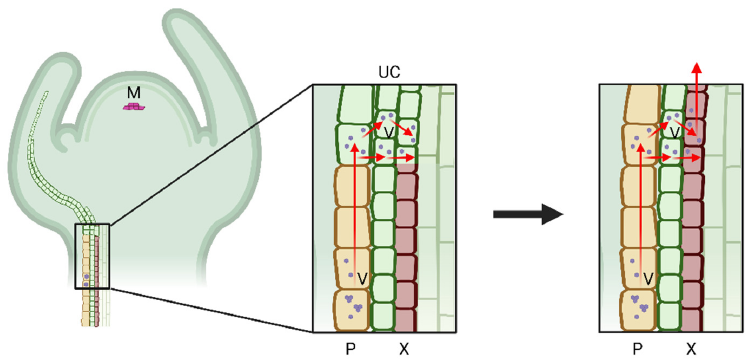
Figure 3. A virus–xylem invasion model illustrates a linkage between virus phloem transportation and virus cell-to-cell movement. The virus moves through the phloem to the distal part of the plant and infects all the undifferentiated cells beneath the meristem, including xylem precursor cells. With the maturation of the xylem cells, which undergo programmed cell death, the virus enters the xylem transpiration stream. The red arrows indicate the virus translocation route. M: meristematic tissue; UC: undifferentiated cells; V: virus; P: phloem; X: xylem. Figure was created with Biorender.com.